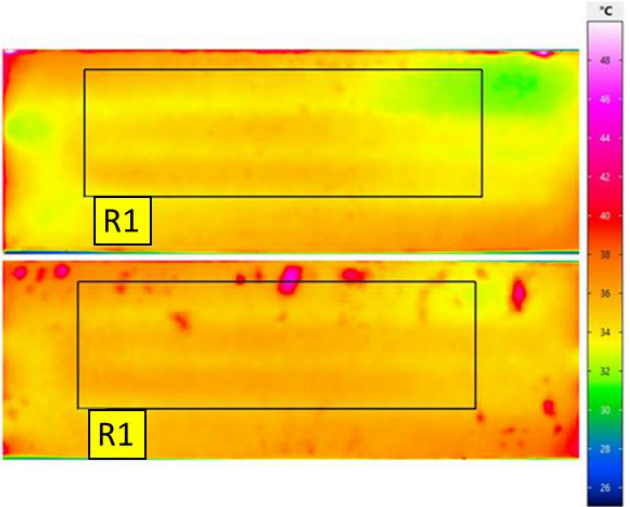
Figure 14. Surface temperature under application of TIM 2 with rectangular (R1) measurement section, ( top ) 1st tape application, ( bottom ) 2nd tape application.